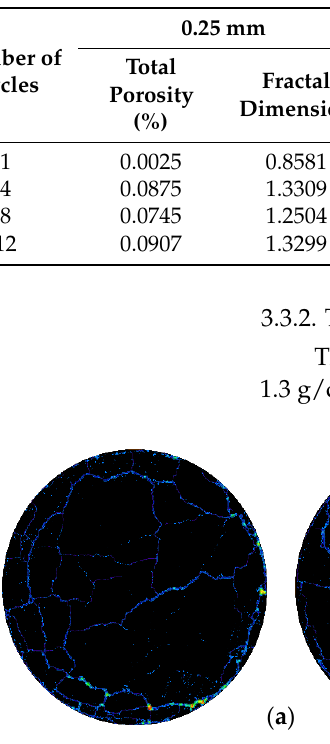
Figure 17. The dry density of 1.4 g/cm 3 : ( a ) 0.25 mm; ( b ) 0.50 mm; ( c ) 2.00 mm; ( d ) 5.00 mm.